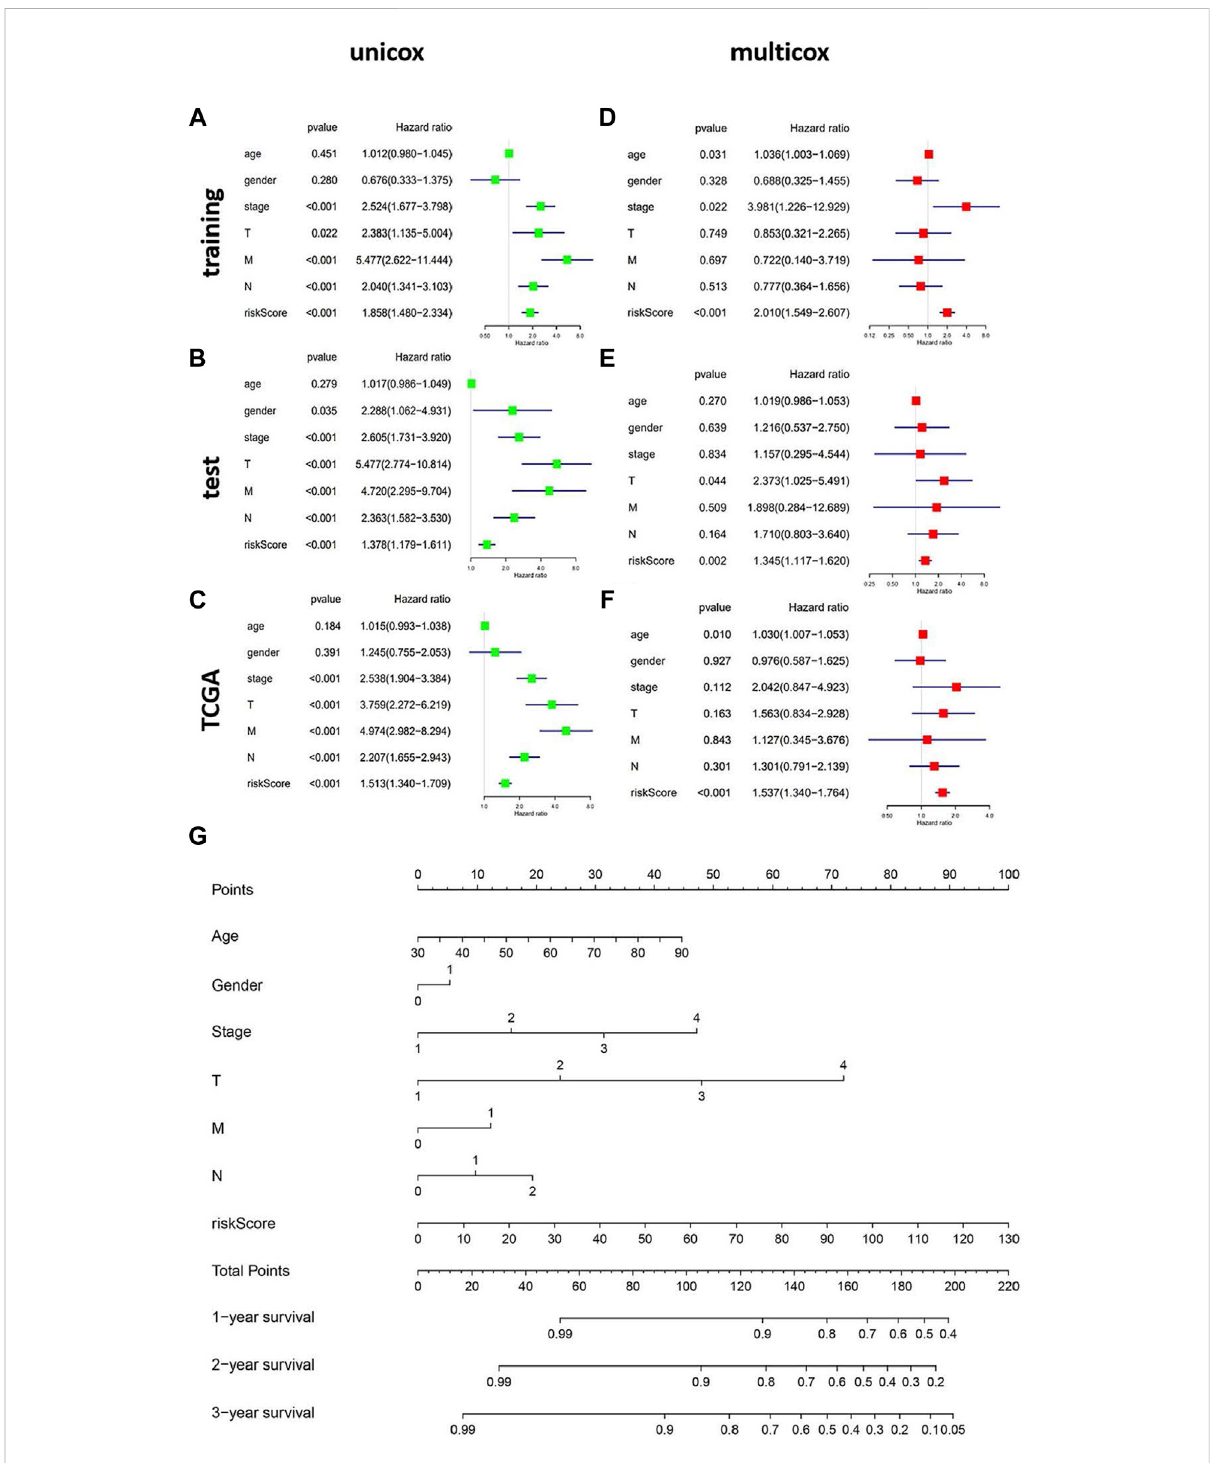
FIGURE 6 The independent prognostic analysis of the genomic instability-related AS signature. Construction of the nomograph model in patients with CRC. ( A – C ) Forest plots of univariate cox regression in the training set, test set, and the entire TCGA set. ( D – F ) Forest plots of multivariate cox regression in the three datasets. ( G ) The nomograph model predicting 1-, 2-, and 3-year survival in patients with CRC based on age, sex, TMN stage, and risk